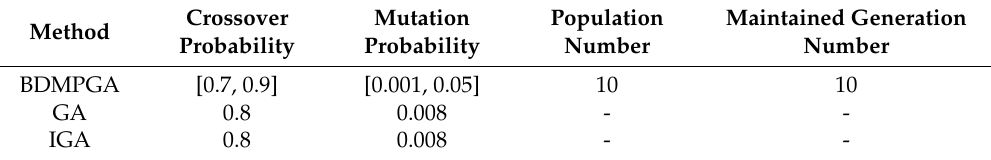
Table 1. Detailed parameter information of the three methods for building displacement. GA—genetic algorithm; IGA—immune genetic